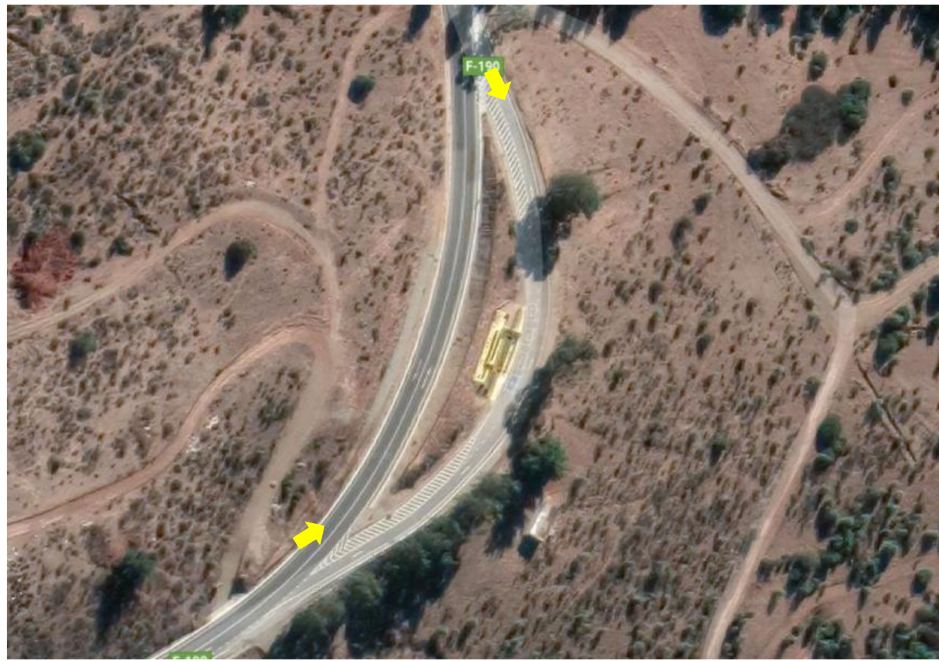
Figure 3. Analyzed area Mirador Ruta F-190, Source: Google